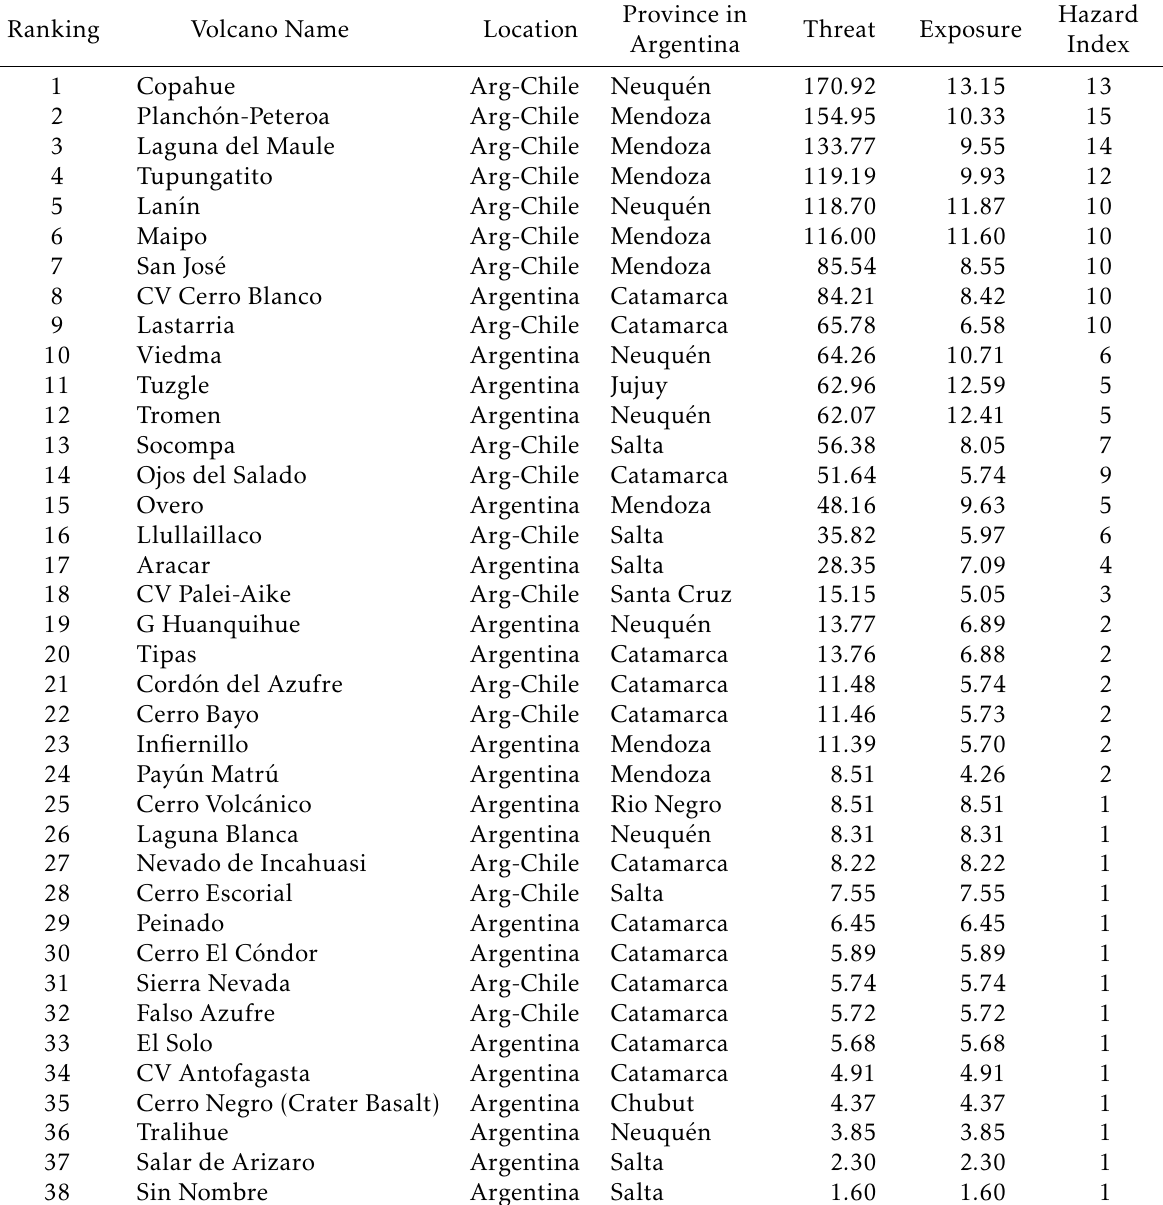
Table 2: Relative Risk Ranking (Threat) for continental Argentina developed by Elissondo et al. [2016]. Arg-Chile indicates volcanoes located within the region close to or on the international